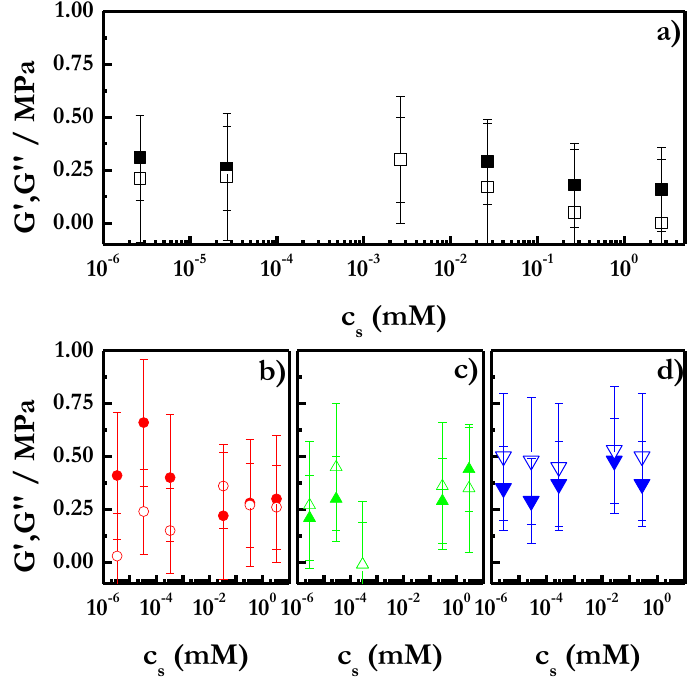
Figure 9. Dependence of G’ (solid symbols) and G’’ (open symbols) on the surfactant concentration, c s , for the different DSPE-PEG+surfactant mixtures studied in this work: ( a ) DSPE-PEG + SLES, ( b ) DSPE-PEG + CB, ( c ) DSPE-PEG + (SLES + CB) (molar ratio 3:2) and ( d ) DSPE-PEG + SLMI. All the mixtures contain a fixed DSPE-PEG concentration of 5 g/L, and their ionic strength and pH were fixed a 40 mM (KCl) and 5.6, respectively.